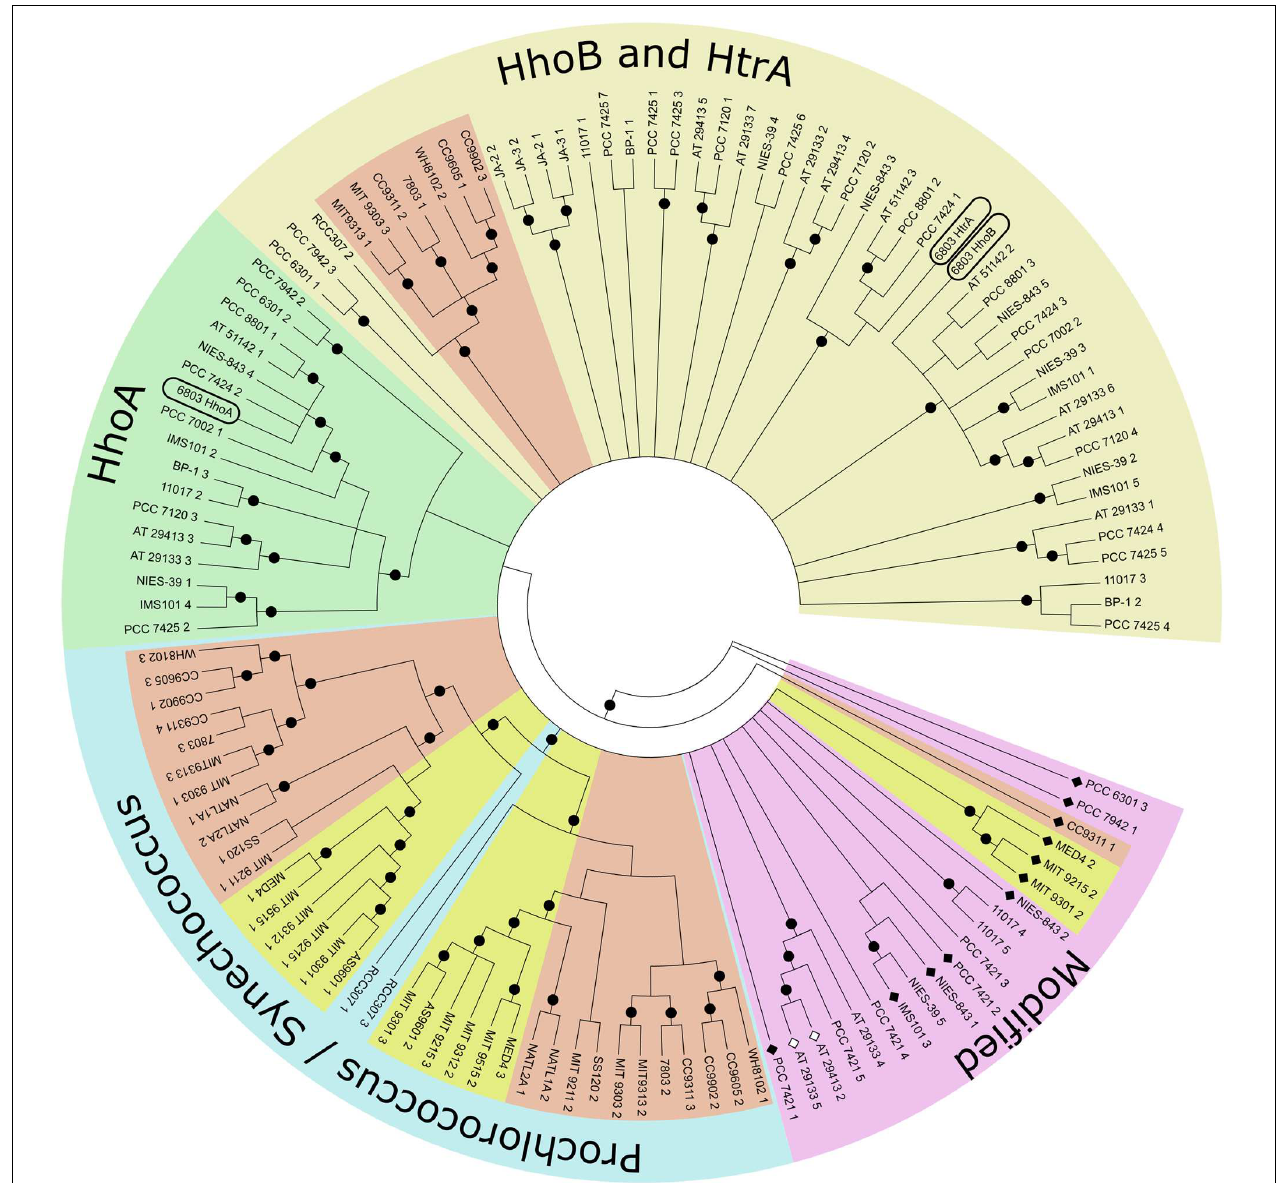
FIGURE 1 | Topological bootstrap consensus tree of cyanobacterial Deg proteases. Phylogenetic tree built using the Maximum Likelihood method from predicted mature protein sequences. The bootstrap consensus tree was inferred from 1000 replicates. Full taxonomic names can be found in Supplementary Table S1 . The last number of each taxon indicates the gene copy of the Deg peptidase of that species. Light yellow: cluster containing Synechocystis 6803 HhoB and HtrA. Light green section contains HhoA of Synechocystis 6803. Light blue circle section contains species of the evolutionary distinct monophyletic groups Prochlorococcus and Synechococcus . Species of Prochlorococcus are known to be high light (yellow) or low light (red) adapted. Also low light adapted Synechococcus are marked in red. In the light purple circle section cluster proteins that are (a) very ancient like Gloeobacter sequences, (b) Deg peptidases